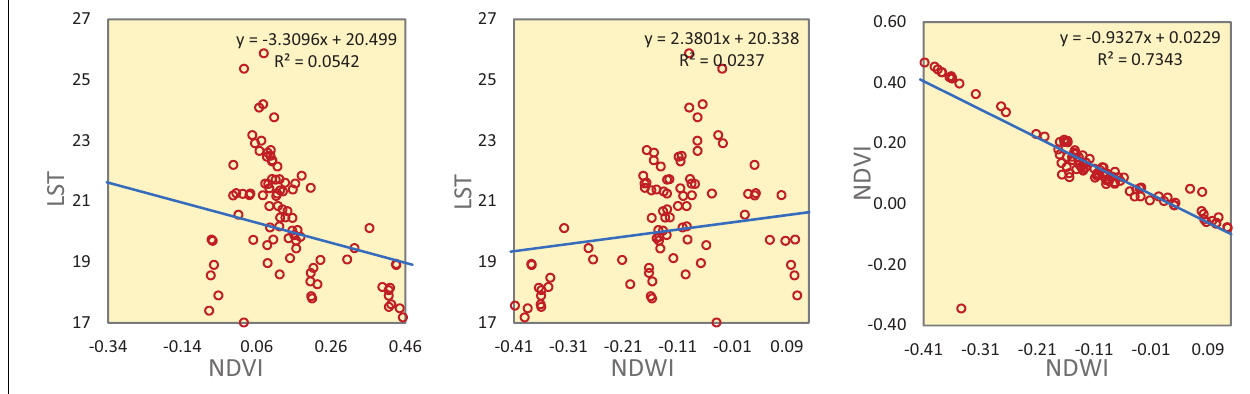
FIGURE 8 | Multiple correlation analysis of LST, NDVI, NDWI, ( N = 100, Significant Correlation at the 0.01 level), of Barddhaman district, 2017. Method Testified in ArcGIS, Erdas Imagine Software, Microsoft Excel and SPSS.